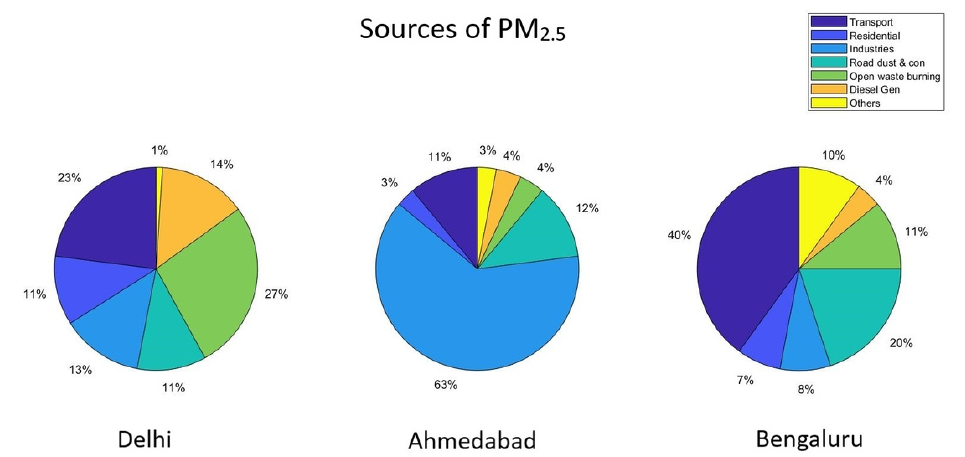
Figure 1. Average percent contributions of major emission sources of PM 2.5 (data from URBAN emissions.info).